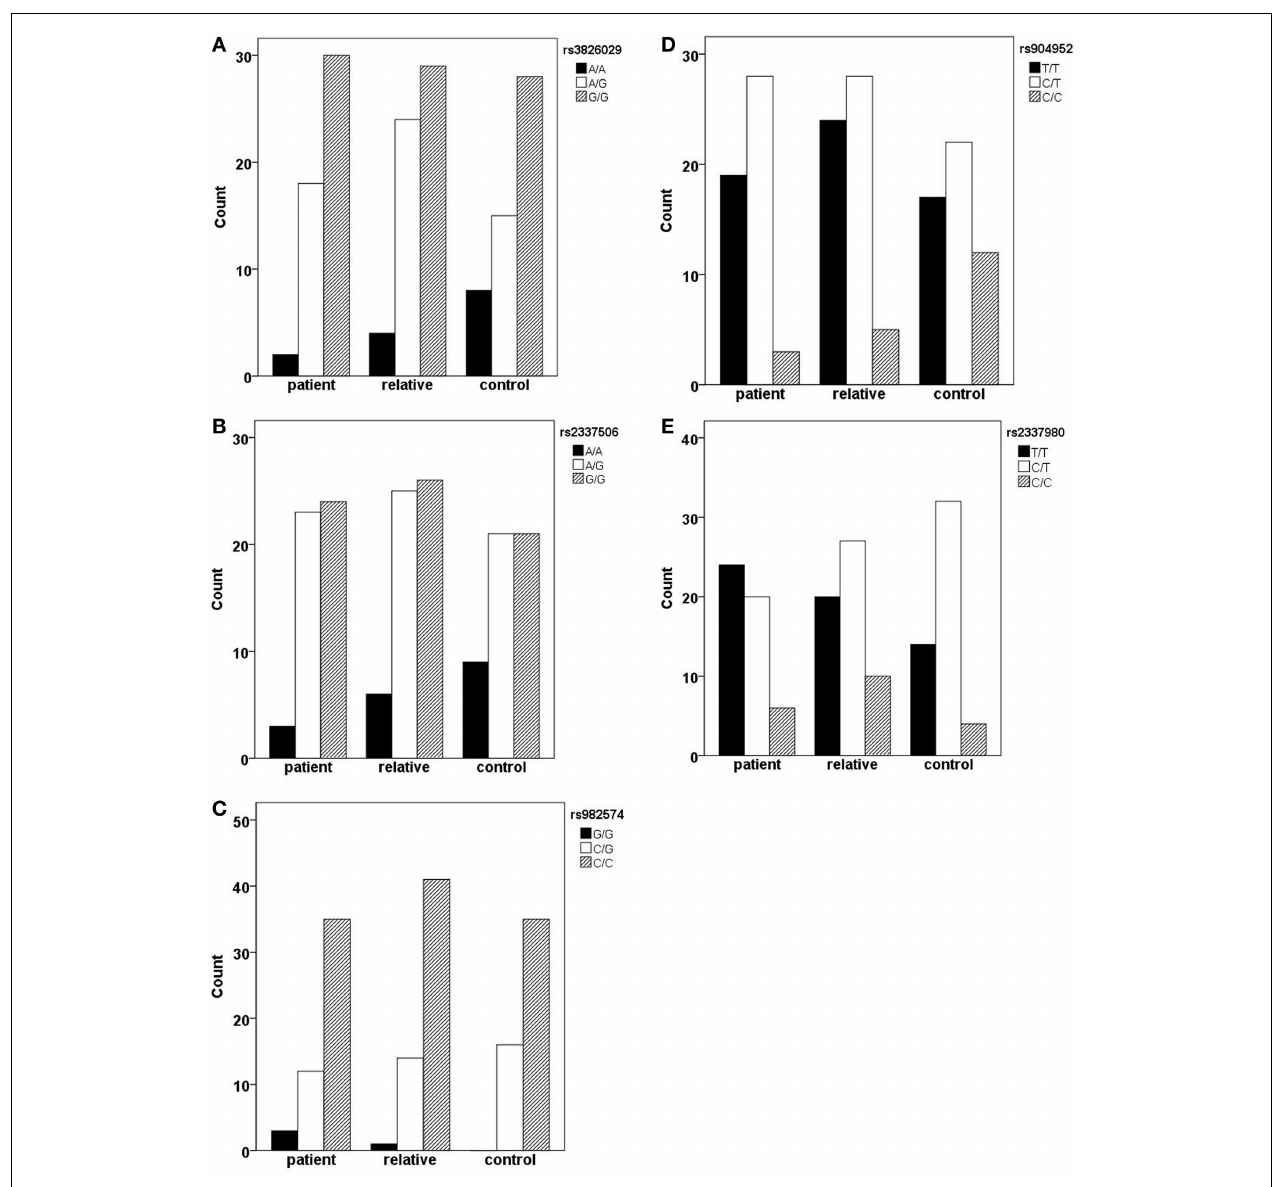
at least one allelic variant the count for relatives is in between patients and controls. However, the differences between groups are not statistically